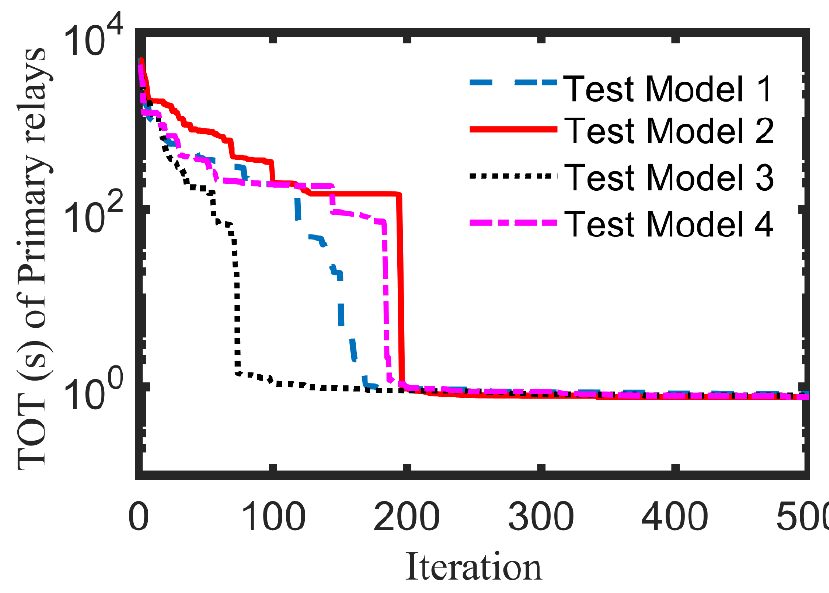
Figure 8. FOF convergence of Agiba test network using scenario 2 settings.